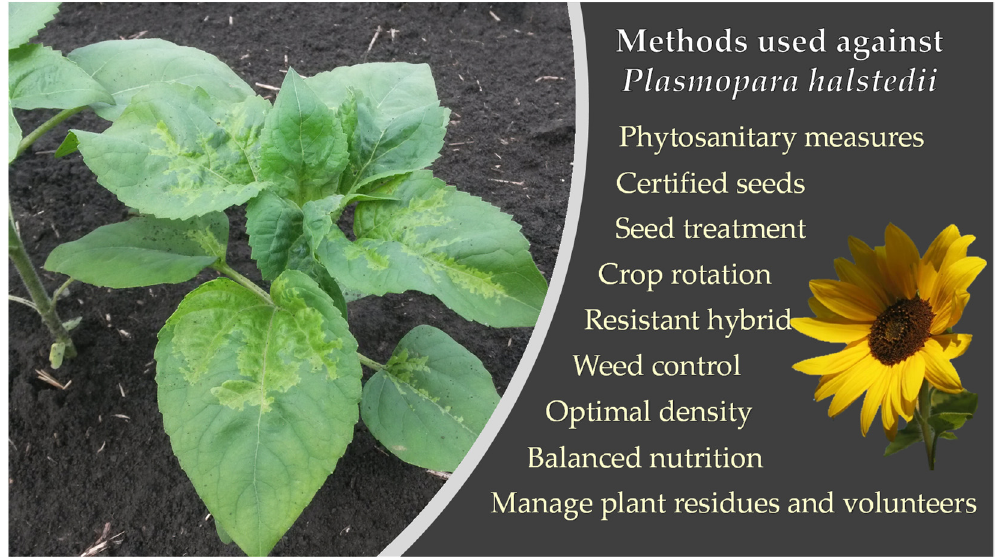
Figure 2. Methods used in the integrated disease management of sunflower downy